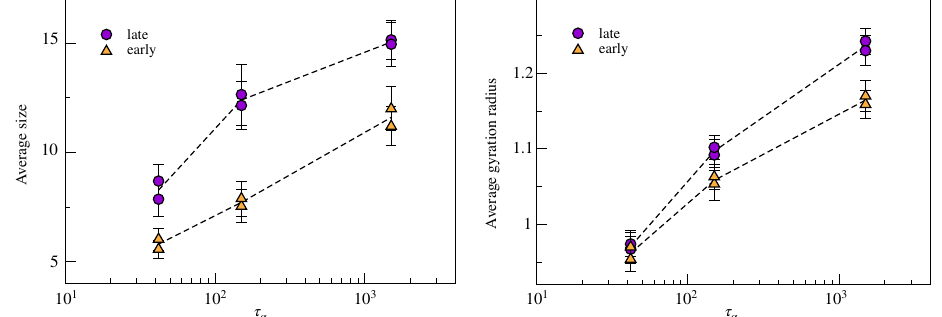
Figure 6. Cluster analysis of the early and late populations of the three pairs of states with equal structural relaxation times τ α . ( Left ) Average number of particles forming a cluster. ( Right ) Average cluster gyration radius. The clusters of both populations increase in both size and gyration radius with the relaxation time. Notably, the clusters of states with equal relaxation times have equal average size and gyration radius within the